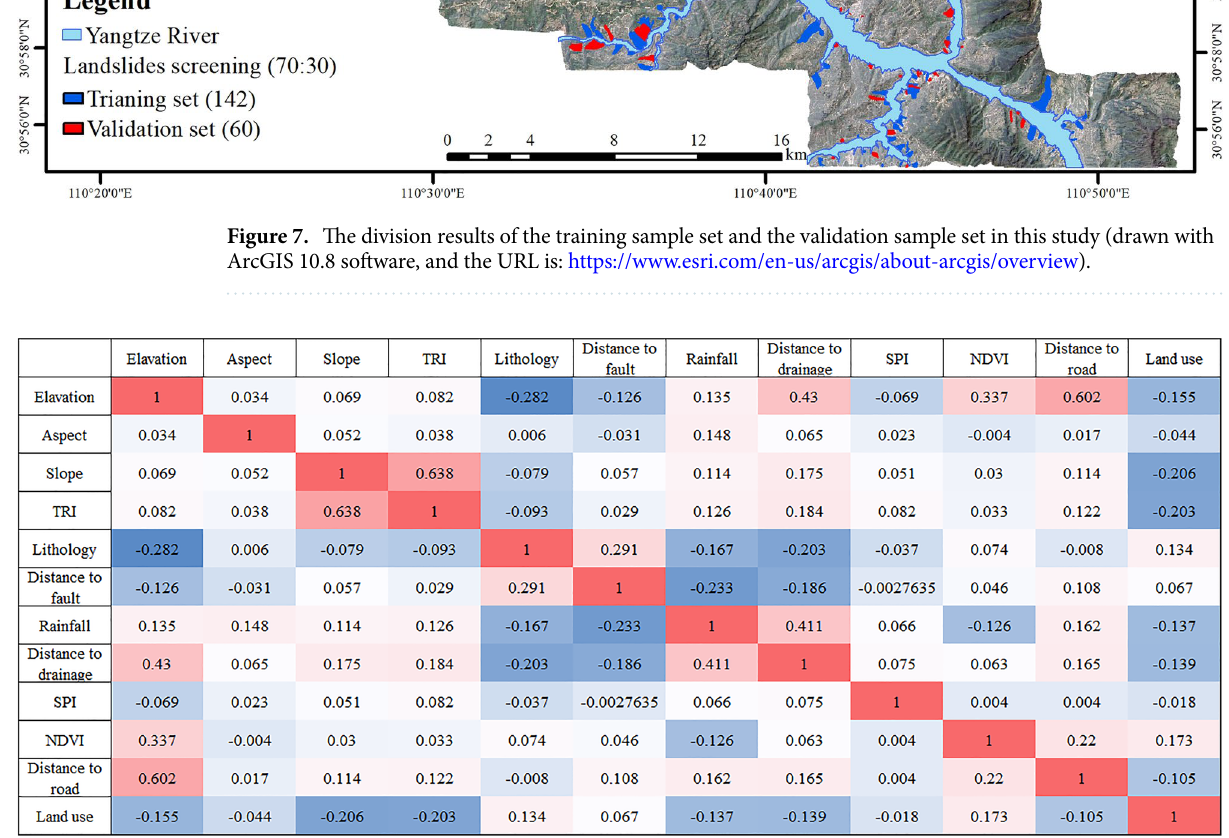
Figure 8. PCC matrix of 12 LSM factors.